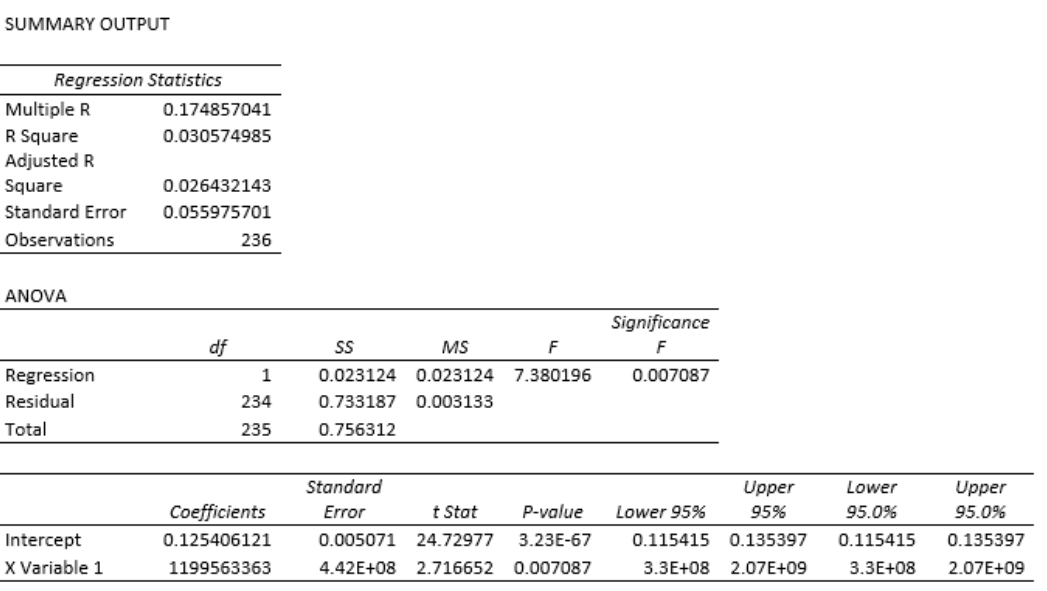
Figure 6. Analysis summary for chlorophyll prediction from MERRA II wet deposition.